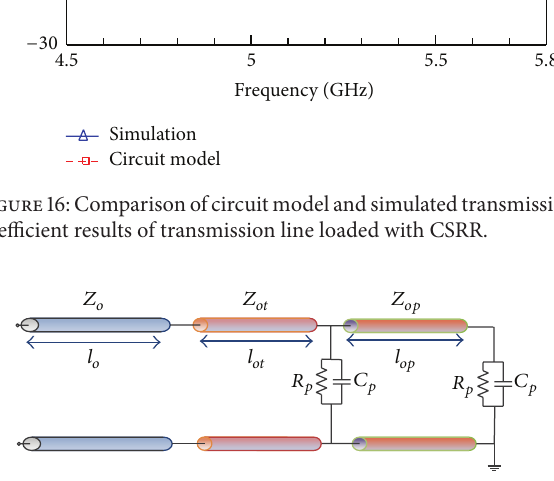
Figure 17: Circuit model of traditional patch antenna using trans- mission lines.